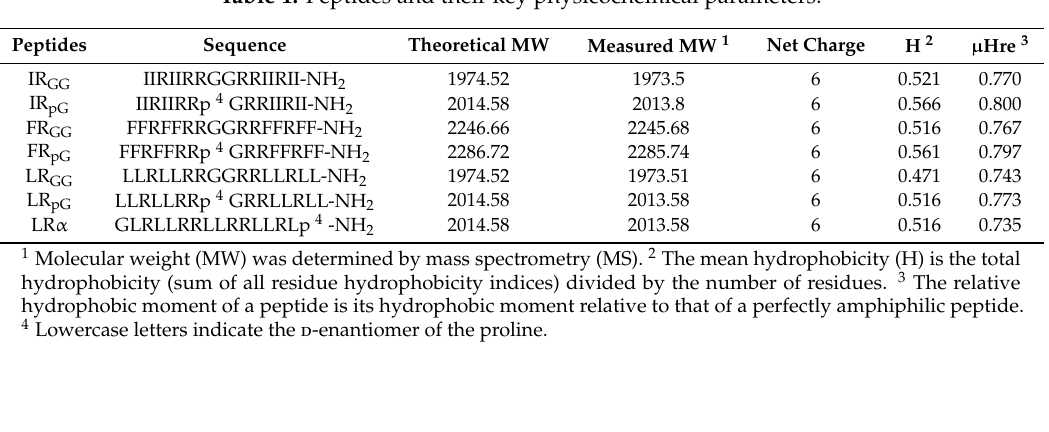
Table 1. Peptides and their key physicochemical